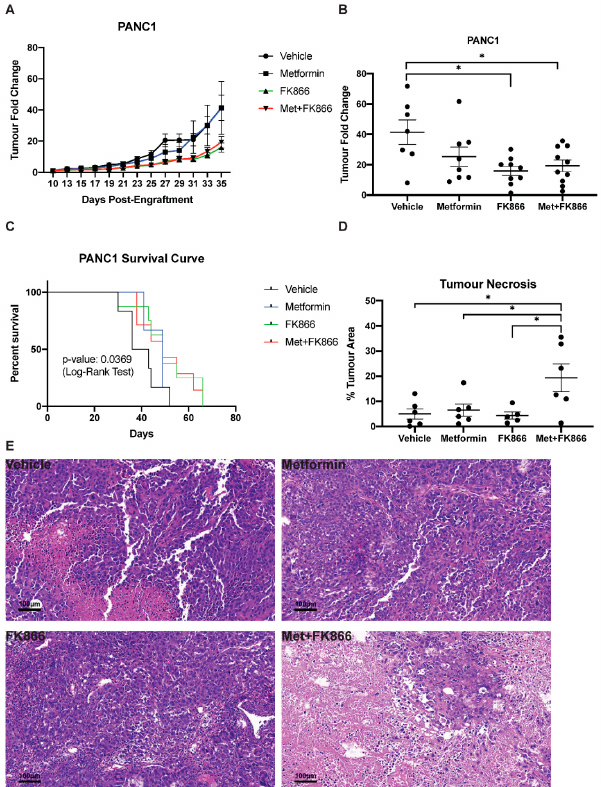
Figure 5. Progression of PANC-1 sub-cutaneous xenografts in nude mice. ( A ) Tumor fold change in mice bearing PANC-1 xenografts treated with Metformin, FK866, Met+FK, or vehicle (5 days a week). Treatment started 11 days post engraftment. ( B ) Tumor volume at day 35 from the mice represented in ( A ). ( C ) Kaplan–Meyer survival curves of PANC-1 tumor-bearing mice receiving different treatments over 65 days. (D-E) Quantification of % tumor necrosis ( D ) by H&E staining ( E ) of PANC-1 tumors, as in ( B ). ( B – D ) * p ≤ 0.05